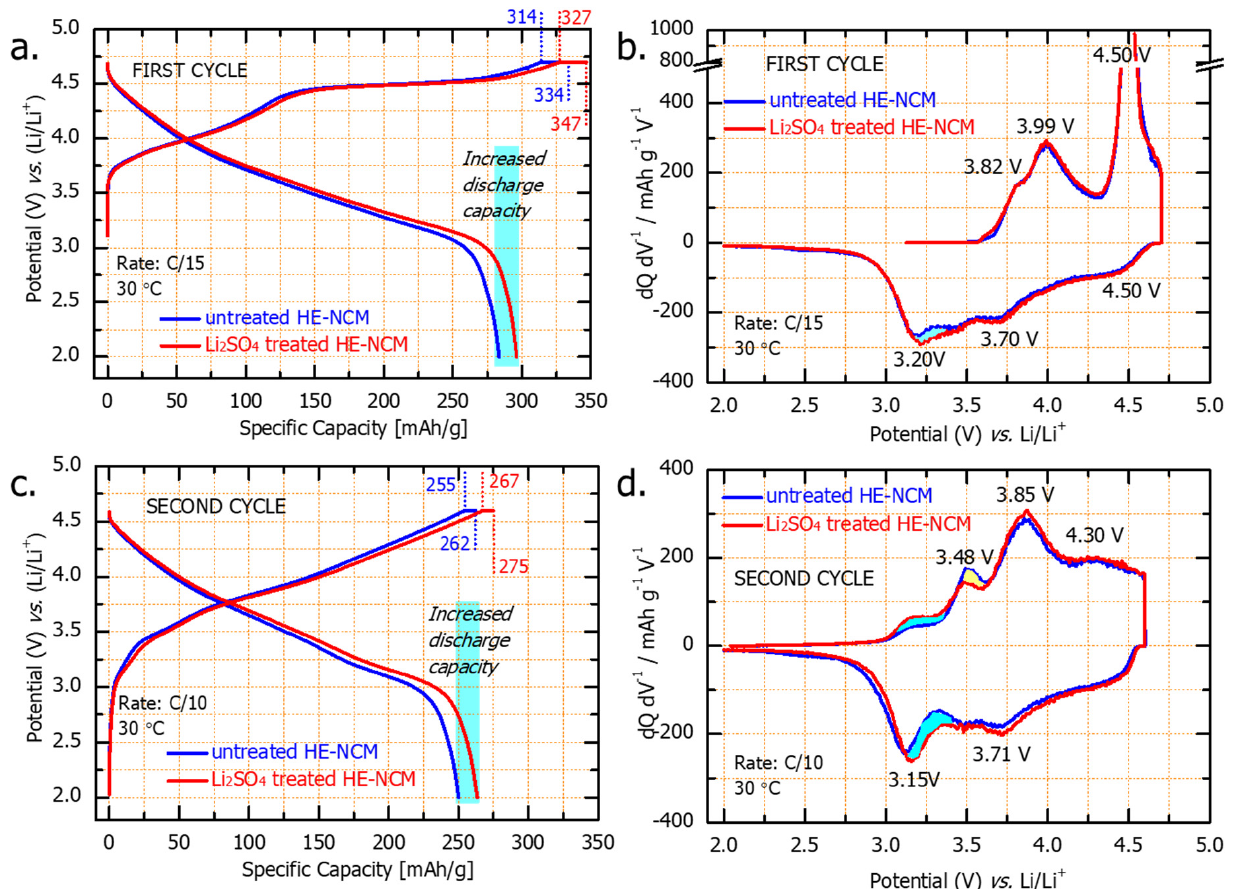
Figure 7. Voltage profiles of the first ( a ) and second ( c ) cycles and the corresponding dQ/dV vs. V profiles ( b , d ) of untreated and Li 2 SO 4 treated HE-NCM cathodes (as indicated) tested in Li cells at 30 °C. Note that a constant voltage step for 3 h was applied at 4.7 V in the initial charge, while all subsequent constant voltage steps at 4.6 V were for 30 min. As a result, the capacities delivered were ~20 mAh/g and ~8 mAh/g, respectively, for the 1st and 2nd cycles, for both untreated and Li 2 SO 4 treated HE-NCM cathodes.